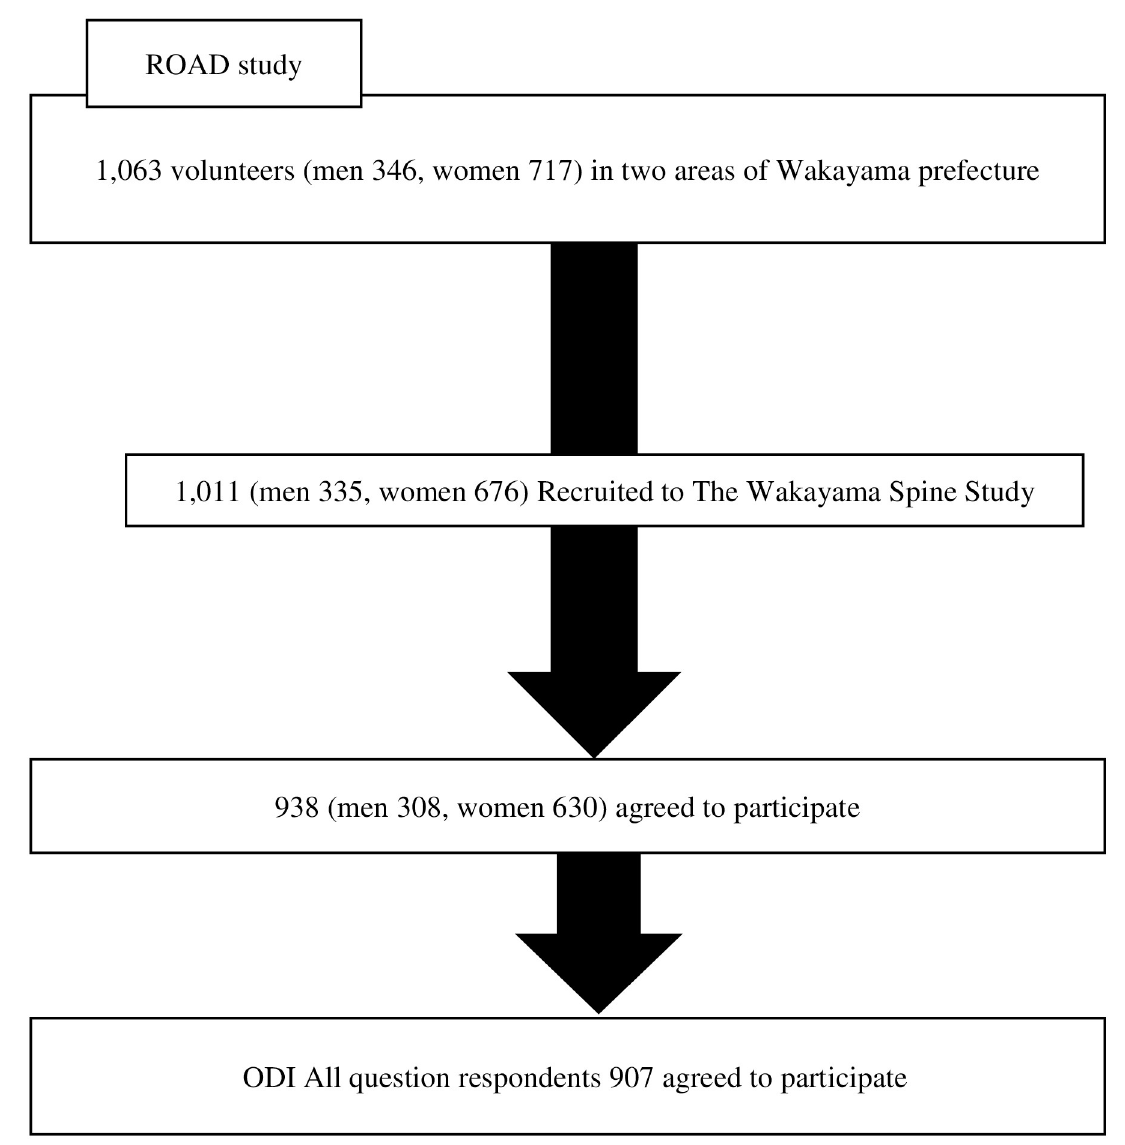
Fig 1. Flow diagram depicting participants recruited to the Wakayama Spine Study from the ROAD study.